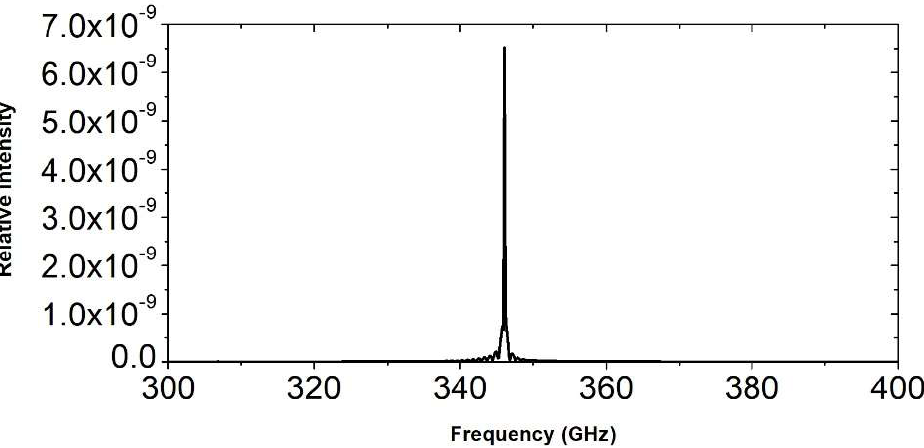
Figure 15. The Fourier transform of output signal.